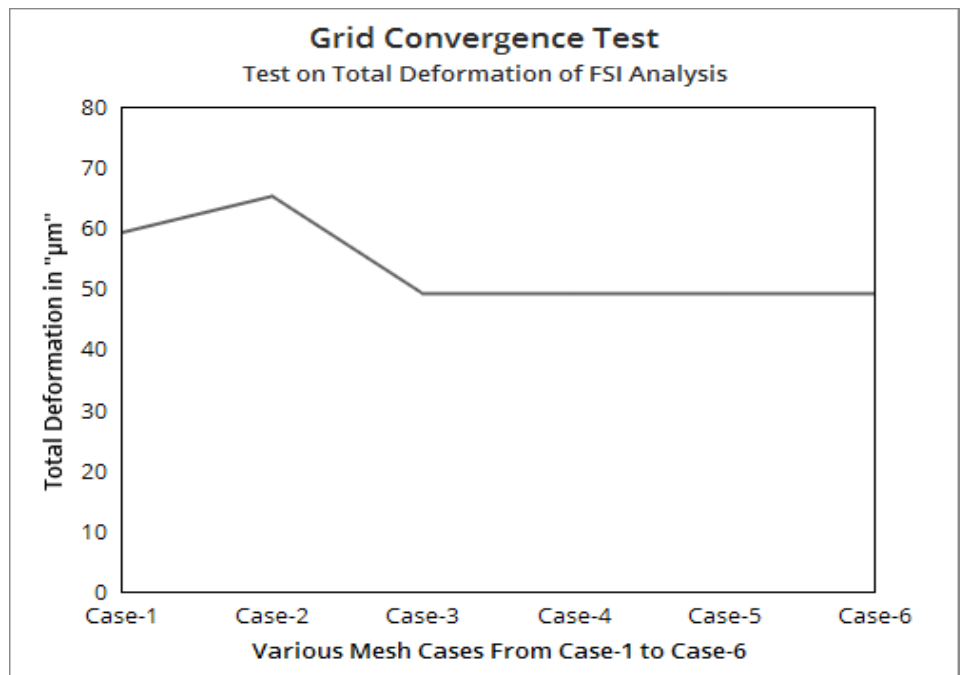
Figure 19. Grid-convergence results for fluid-structure-interaction (FSI) analysis.